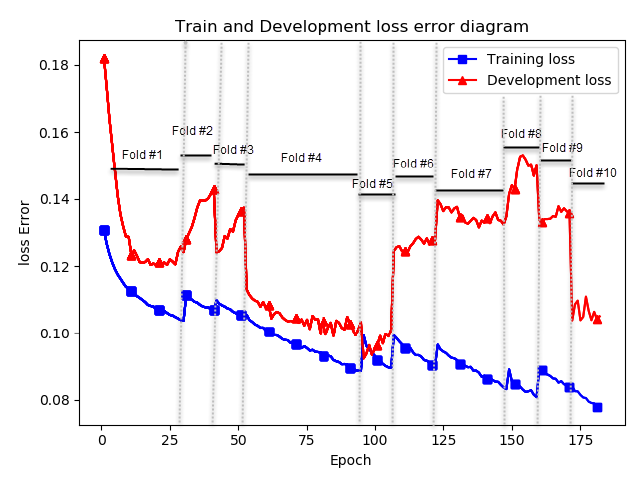
Fig. 6. Training and development loss error diagrams for conscientiousness trait classification in the UTS dataset evaluated by the S10-Fold CV method.